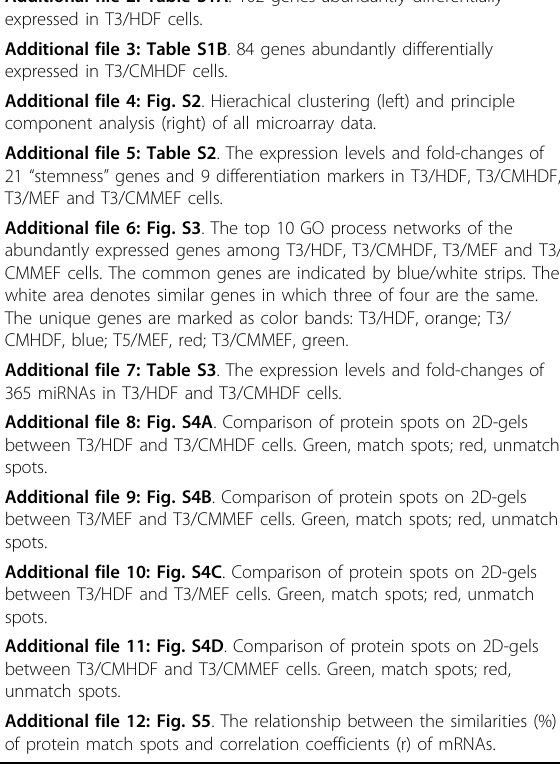
Additional file 9: Fig. S4B . Comparison of protein spots on 2D-gels between T3/MEF and T3/CMMEF cells. Green, match spots; red, unmatch Additional file 10: Fig. S4C . Comparison of protein spots on 2D-gels between T3/HDF and T3/MEF cells. Green, match spots; red, unmatch Additional file 11: Fig. S4D . Comparison of protein spots on 2D-gels between T3/CMHDF and T3/CMMEF cells. Green, match spots; red, unmatch spots. Additional file 12: Fig. S5 . The relationship between the similarities (%) of protein match spots and correlation coefficients (r) of mRNAs.